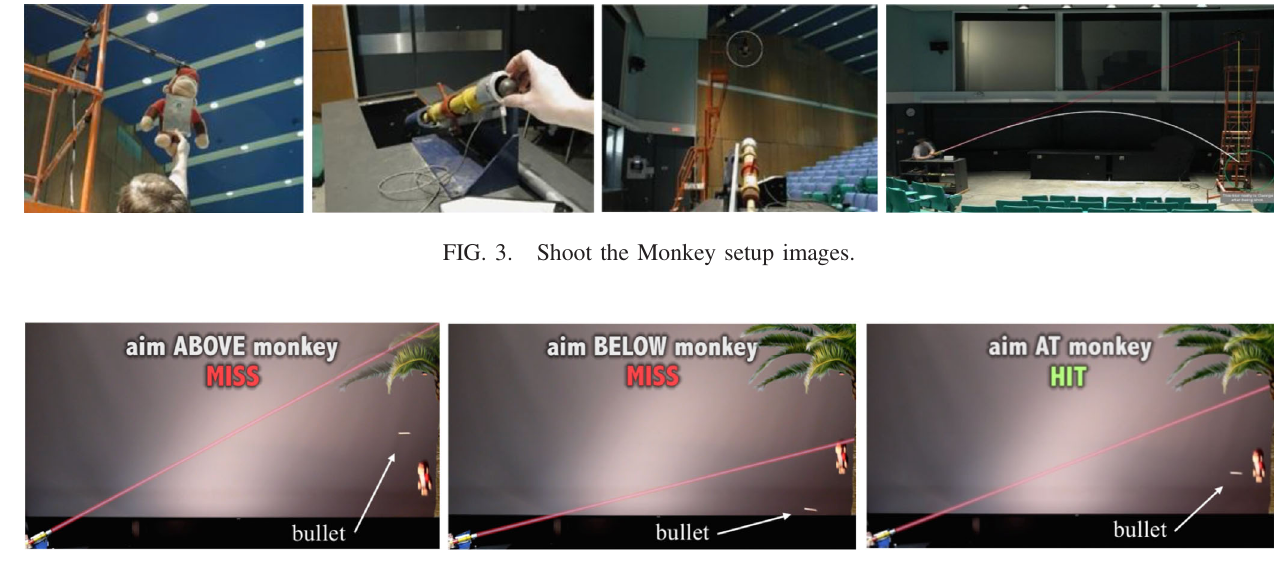
FIG. 4. Shoot the Monkey, contrasting cases with different aim angles.